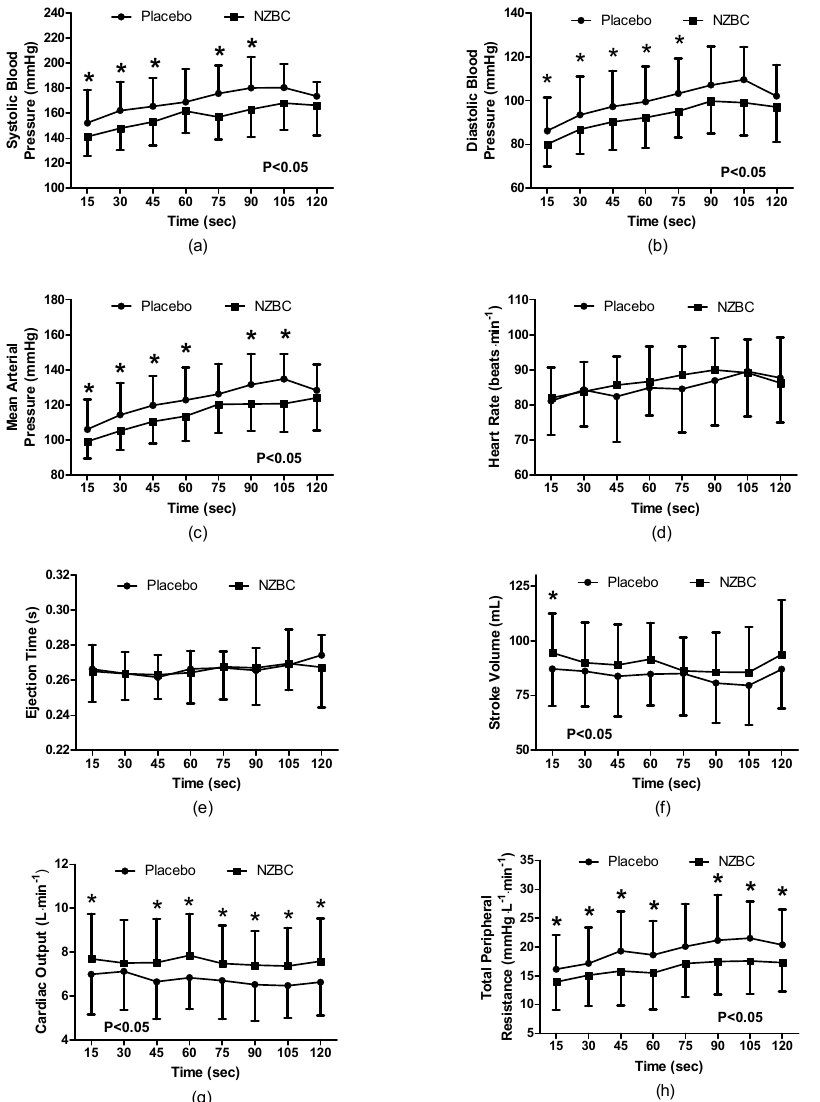
Figure 1. ( a ) Systolic Blood Pressure; ( b ) Diastolic Blood Pressure; ( c ) Mean Arterial Pressure; ( d ) Heart Rate; ( e ) Ejection Time; ( f ) Stroke Volume; ( g ) Cardiac Output; ( h ) Total Peripheral Resistance during a 120-s 30%iMVC of the quadriceps muscle for placebo and after 7-days intake of NZBC (New Zealand blackcurrant) extract capsules. Data are mean ± SD. * difference between placebo and NZBC extract ( p < 0.05).